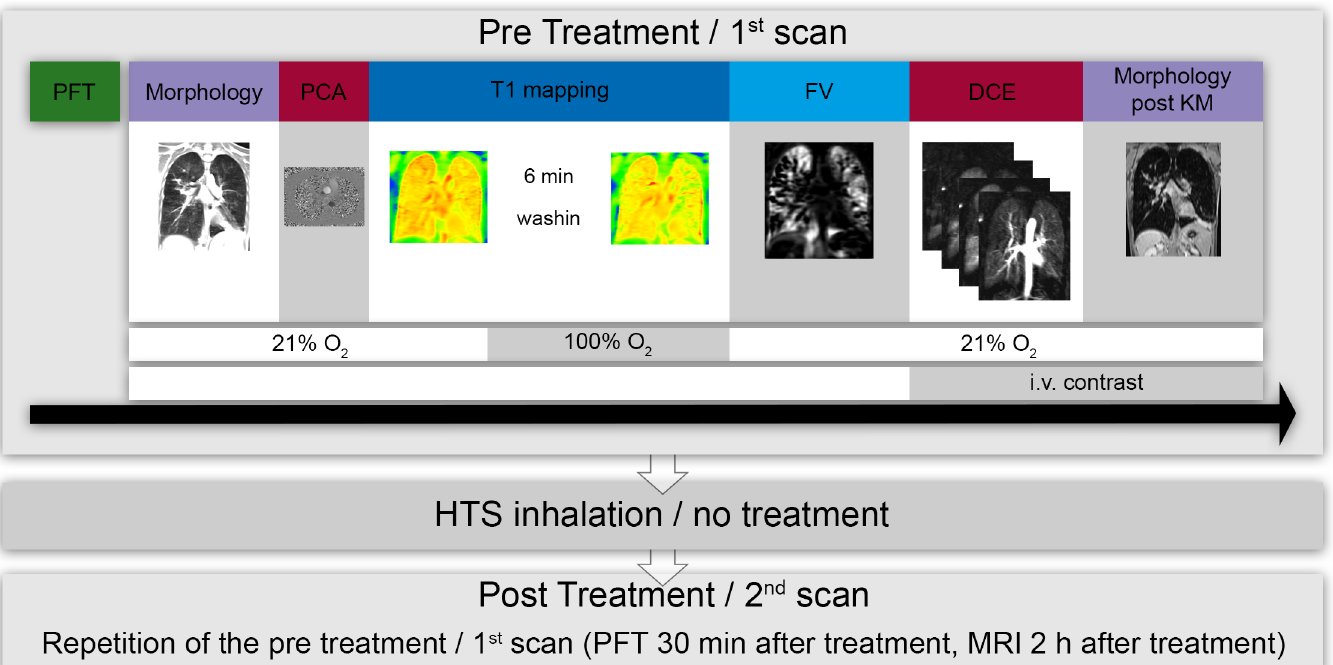
Fig 2. Study protocol. Pulmonary function testing (spirometry and multiple breath nitrogenwashout (MBW)) were performed 60 to 90 minutes prior to the pre treatment scan / 1 st scan. MRI was performed as follows: first, morphological images were assessed followedby phase contrast angiography (PCA) in the ascendingaorta. Afterwards T1 mappingbreathingroom air and again after six minutes of 100% oxygen wash-intime was acquired.RegionalFractional Lung VentilationMRI (FV) was then acquiredunder normoxicconditions. Then for assessment of pulmonary parenchymal perfusion, dynamic contrast enhanced(DCE) MRI was carried out followedby a morphologicalsequencepost i.v. contrast. Afterwards inhalation treatment with hypertonic saline (HTS, treatment group) or no treatment (control group) was performed and the PFT (30 minutes after treatment) and MRI (2 h after treatment) were repeated. Healthy volunteersunderwentone scan using the same functionallung MRI protocol, except for DCE-MRI and phase-contrast